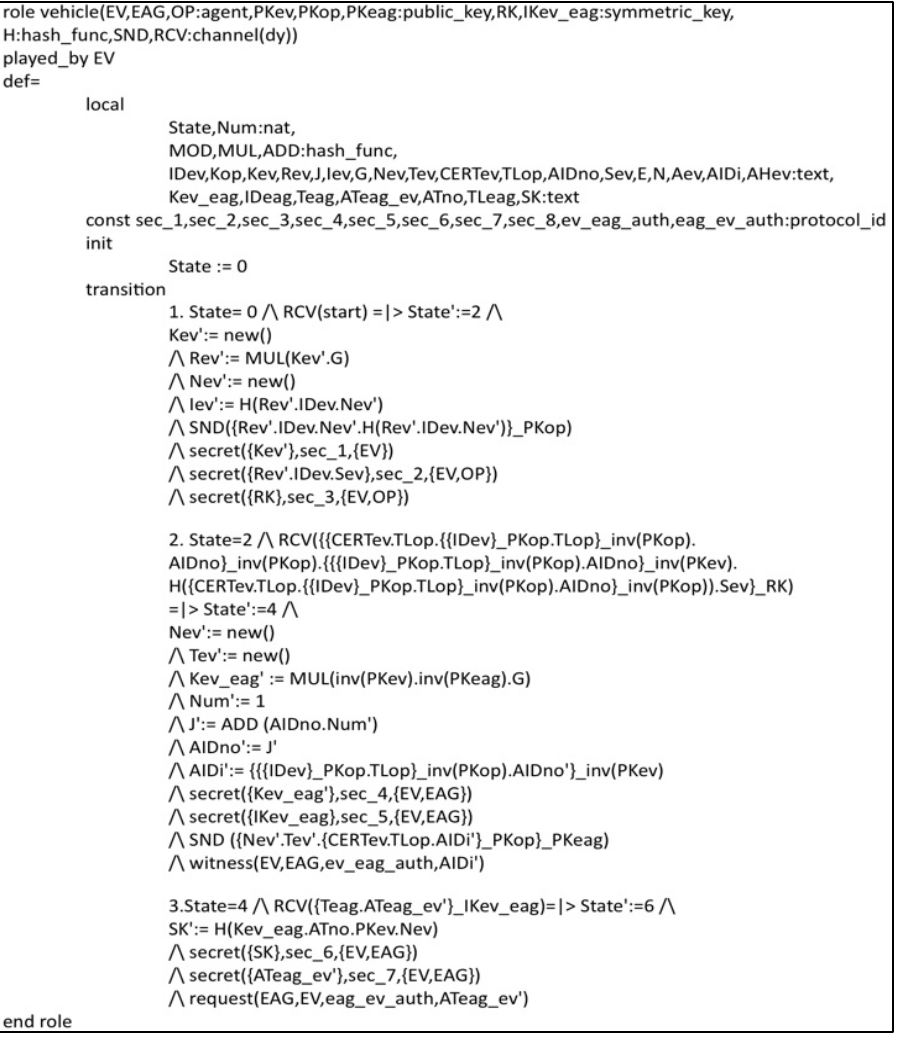
Figure 8. Mutual Authentication Specification of